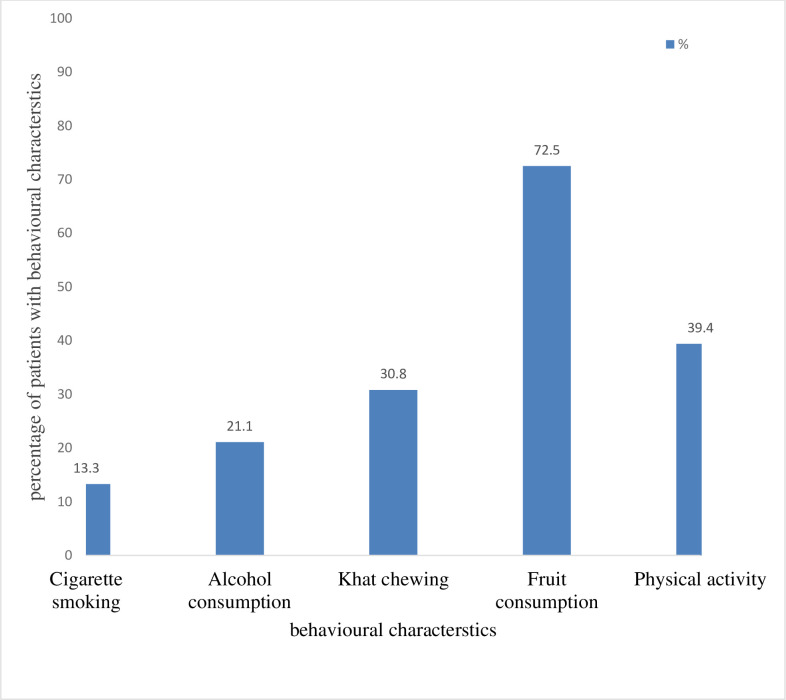
Behavioral factors among respondents admitted to medical ward with metabolic syndromes, in Jimma Medical Center, South west Ethiopia from April-May 2019.